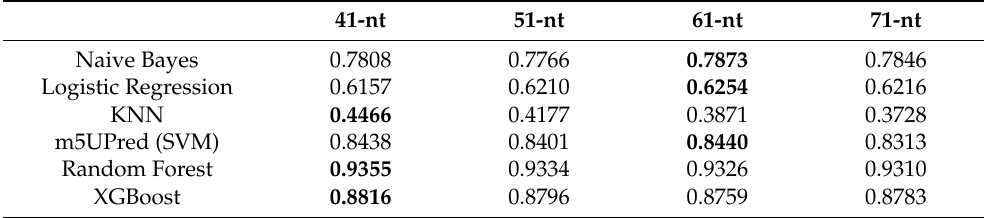
Table 1. Accuracy under different baseline models using different sequence